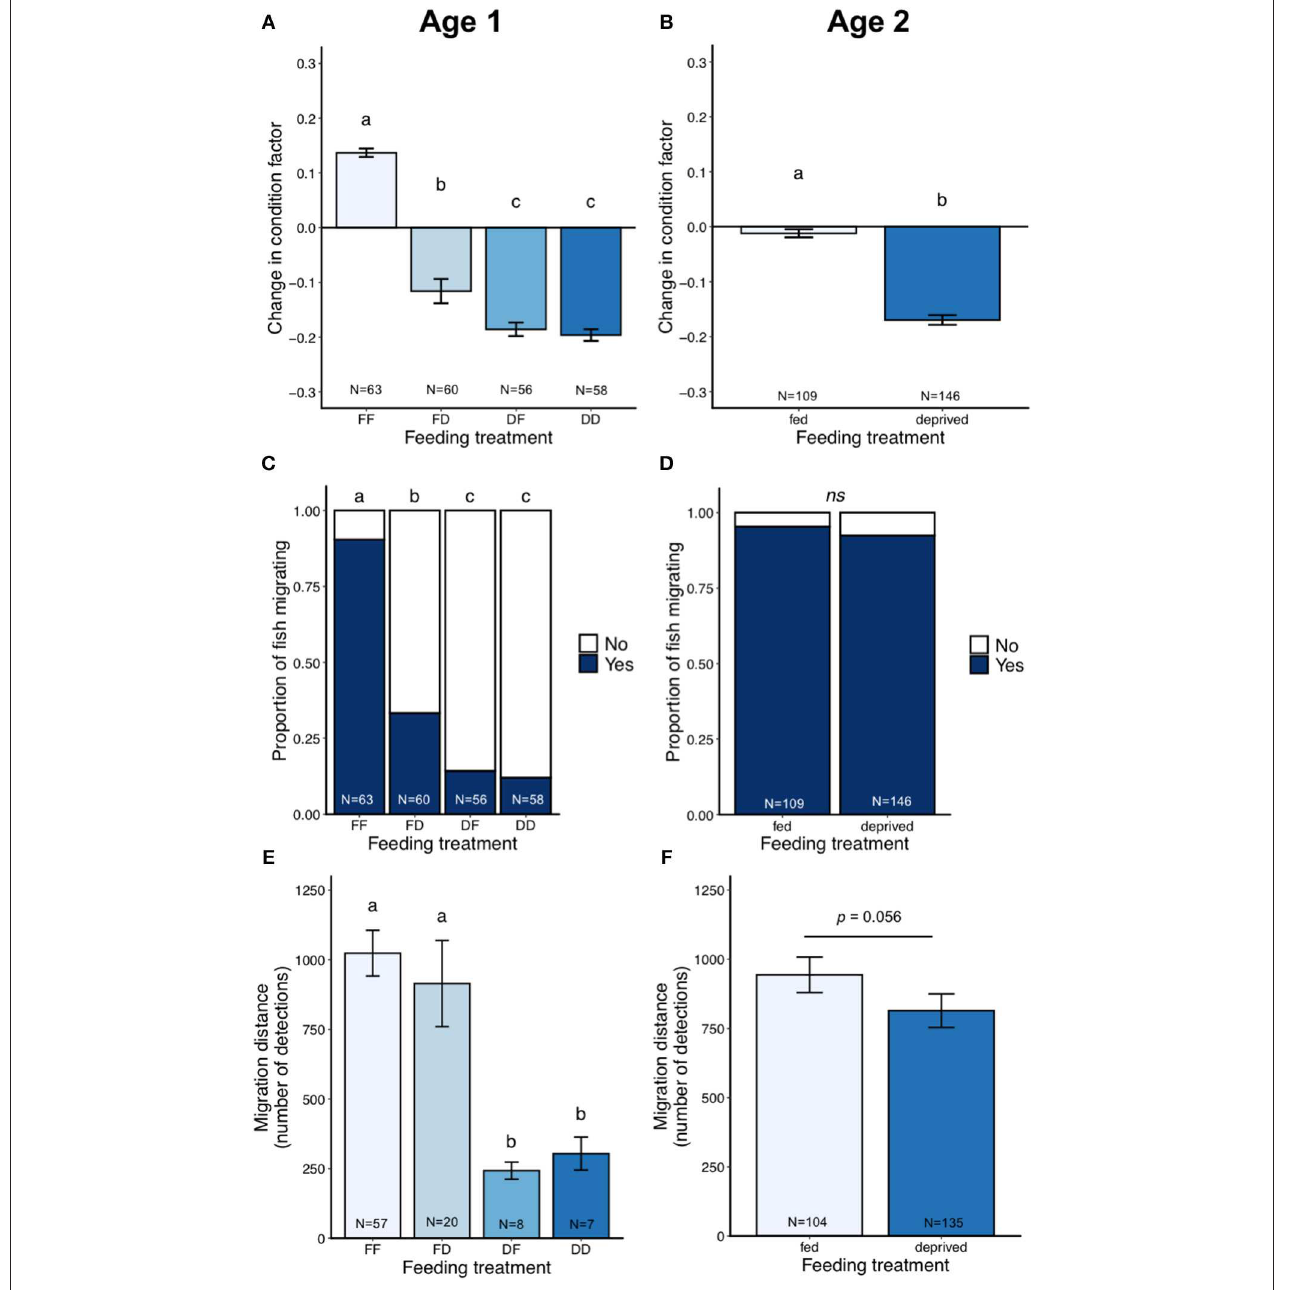
FIGURE 3 | Results from the laboratory migration study (part one), showing change in condition factor (A,B) , proportion of fish migrating (C,D) , and migration distance (number of detections) in the migration pool (E,F) for the age one and age two cohorts. Error bars represent ± 1 standard error of the mean. Different letters show statistical differences among treatment